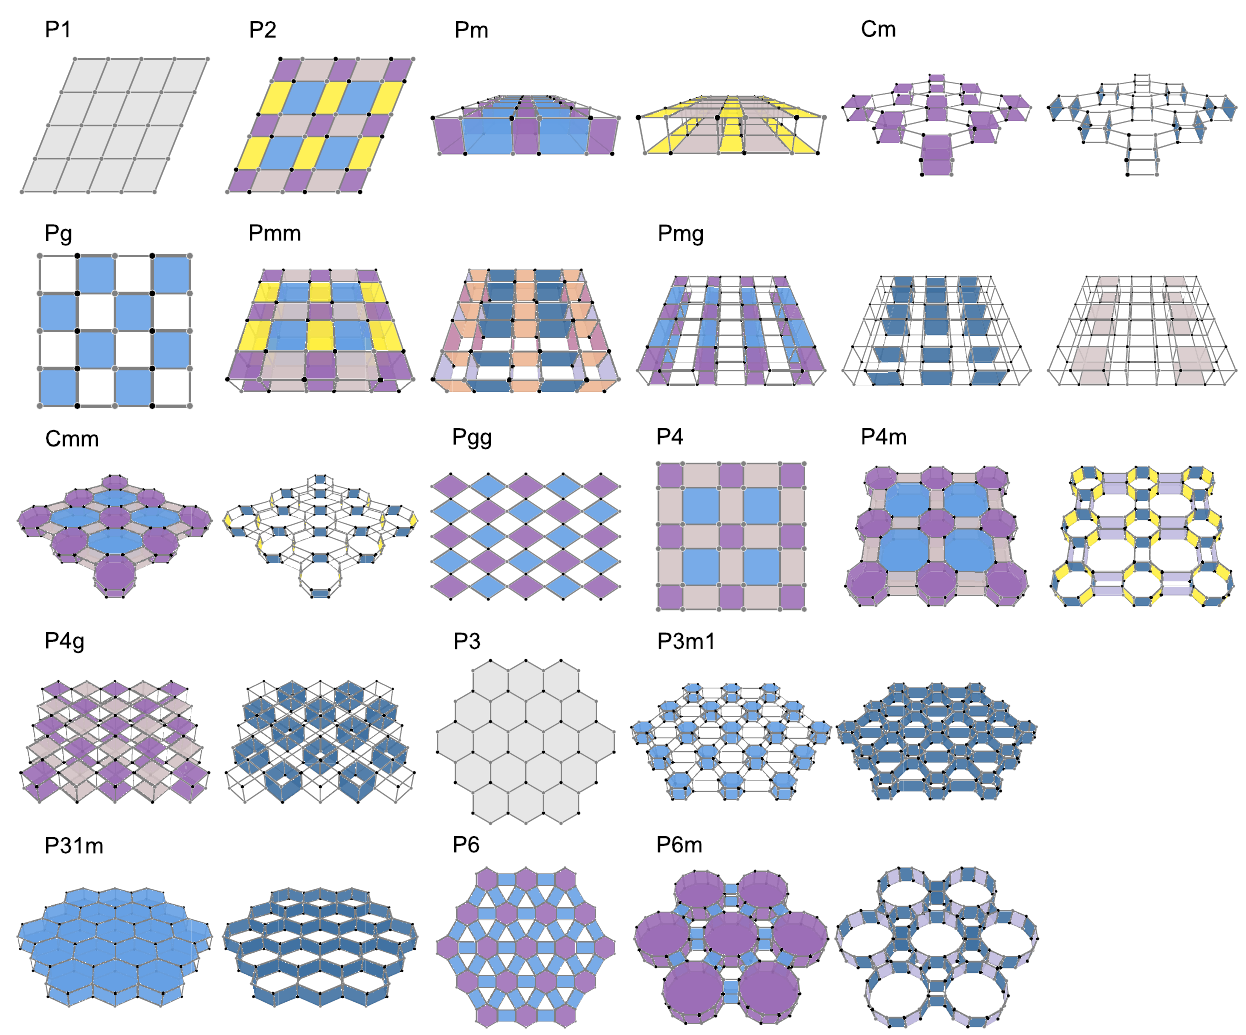
Fig.3|Illustrationforthecanonicalmodelsof17wallpapergroups. Foreachwallpapergroup,thecohomologyinvariantsarerealizedbyindependent fl uxes Φ a ∈ {0, π } on the lattice, which are distinguished by different